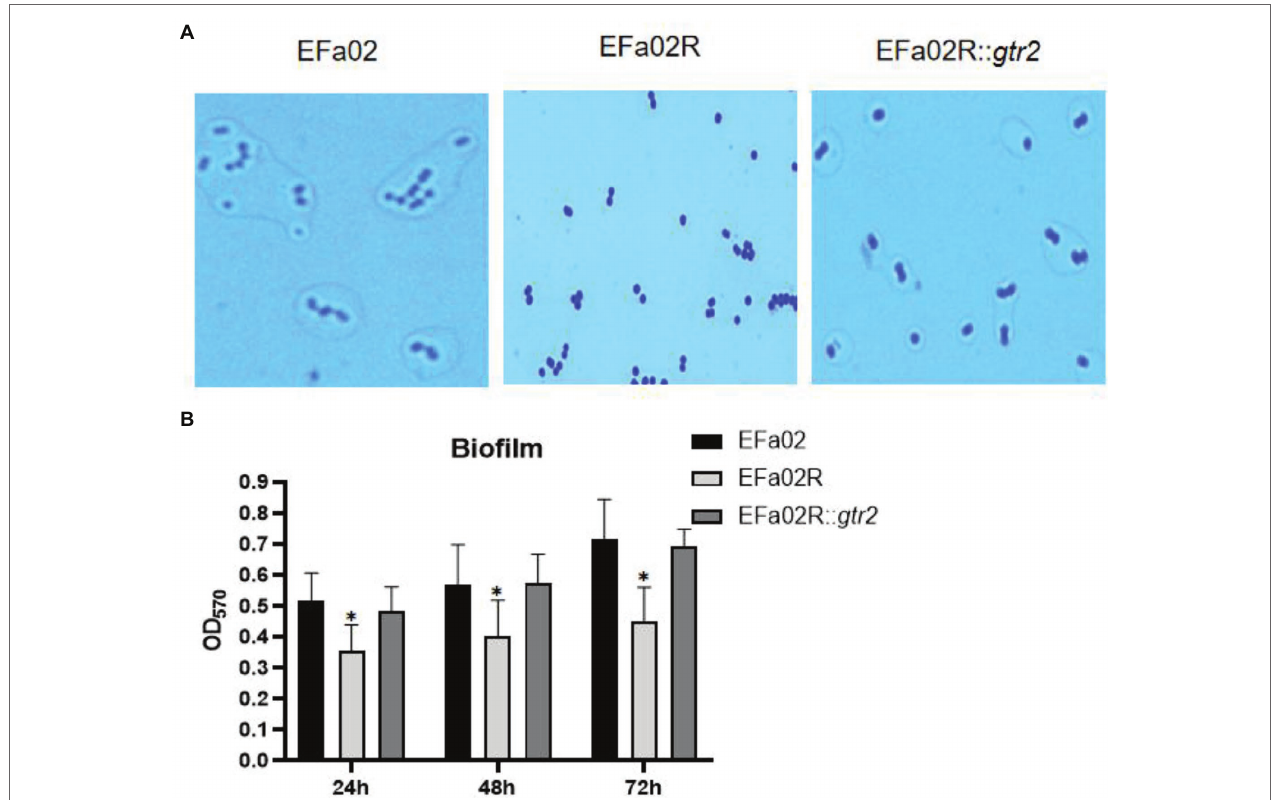
FIGURE 6 | (A) Capsule staining of EFa02, EFa02R, and EFa02R:: gtr2. Capsule staining showed that EFa02 and EFa02R:: gtr2 have the capsule, but EFa02R lost the capsule. (B) The biofilm mass of EFa02R was less than those of EFa02 and EFa02R:: gtr2 ( * p < 0.05) at the given time